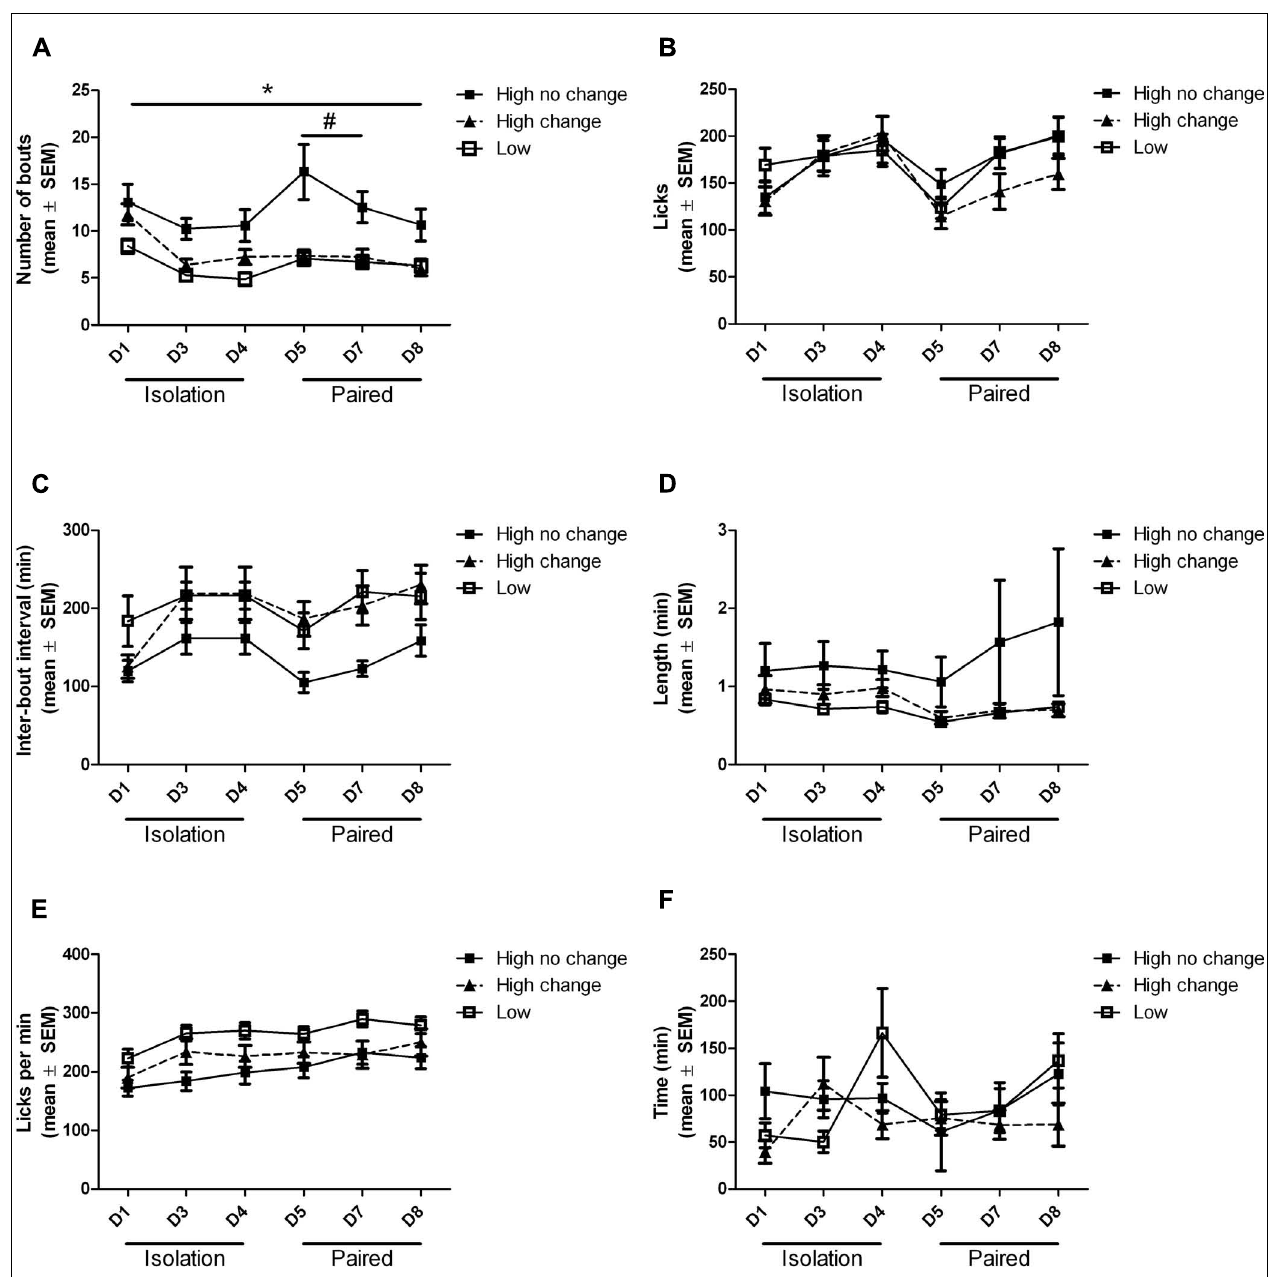
FIGURE 5 | Ethanol drinking bout features. Bout features of high drinkers that did (black triangle) or did not (black square) change ethanol intake when paired with low drinkers (white square) are shown throughout isolation and pair housing.The number of bouts of ethanol drinking (A) , the average length of bouts as measured by number of licks (B) and time (D) , the average time